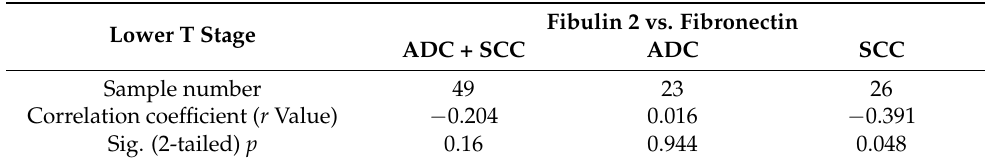
Table 2. Pearson correlation coefficients between Fibulin 2 and Fibronectin protein expression in primary lung tumors.